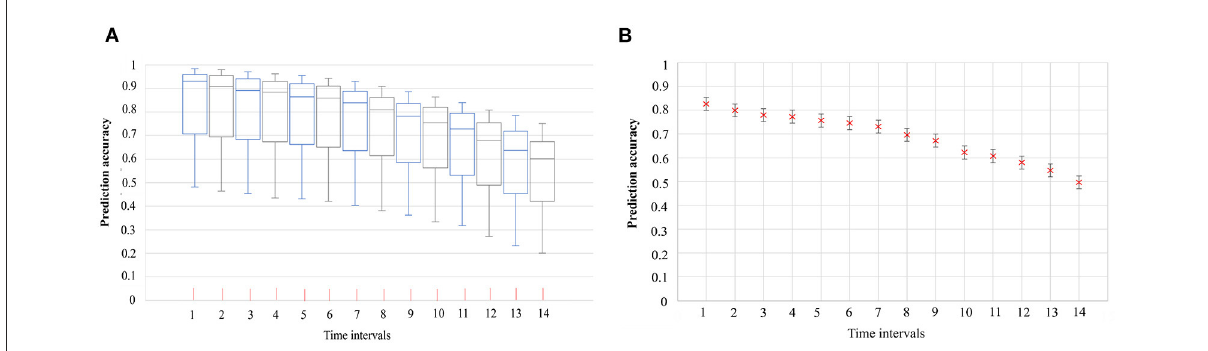
FIGURE3 The accuracy of the predicted risk of COVID-19 symptom onset by urban-community-level WKDE models, and 95% confidence interval of prediction accuracy (28–31). (A) Accuracy of the predicted risk of COVID-19 symptom onset by urban-community-level WKDE models. The predicted onset risk is a normalized value of between 0 and 1, hence, indicating risk relative to the highest predicted risk among all locations, on the date for which the risk of symptom onset is predicted, hereafter termed “the prediction date”. The prediction accuracy is defined as the percentage of onset cases in those areas for which the predicted onset risk was higher than 0.8 on the prediction date. The time interval denotes the period between the base date (The base date refers to the date on which the onset risk for the next 14 days is predicted) and the date of prediction. The horizontal line in the box denotes the median, while the lower and upper edges of the box represent the respective first and third quartiles. The lines emanating from the box upwards and downwards represent the respective maximum and minimum values. (B) 95% confidence interval of the mean accuracy of the predicted risk of COVID-19 symptom onset by urban-community-level WKDE